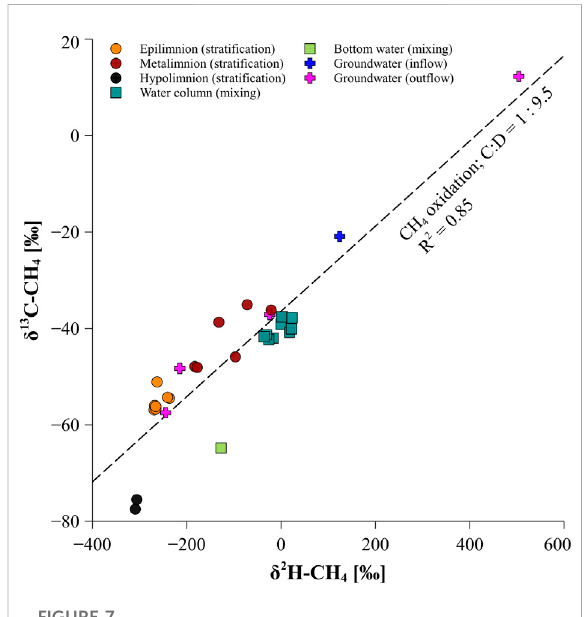
FIGURE 7 2-dimensional isotope plot of water column and groundwater CH 4 data from the strati fi cation and mixing period. The dotted line represents the ratio of 13 C to 2 H (C:D) enrichment during CH 4 oxidation in the water column and groundwater at lake